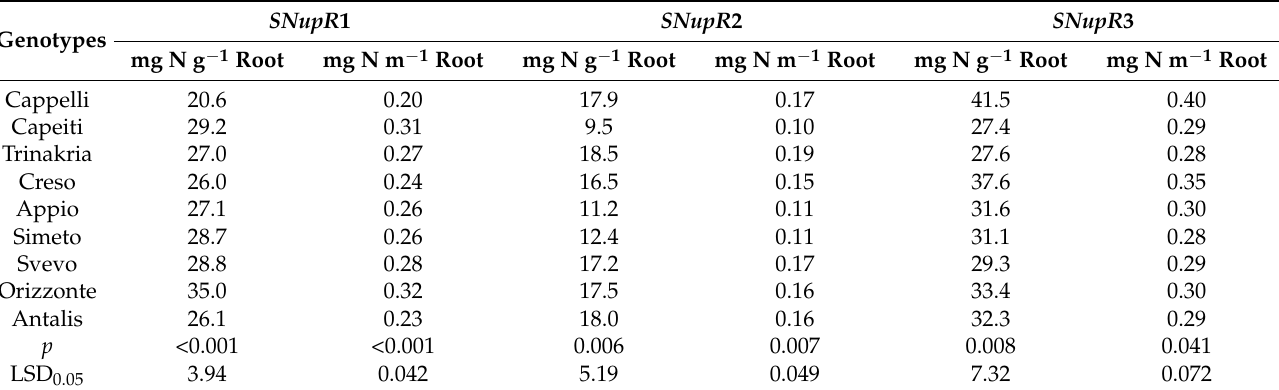
SNupR 1 represents the amount of N taken up by the plants per gram or meter of root at Time 1; SNupR 2 and SNupR 3 represent the amount of N taken up by plants in the 7 and 35 days following fertilization, respectively (calculated as the difference between the amounts of N at Time 2 and Time 3 compared to Time 1, respectively), per gram or meter of root at Time 1.